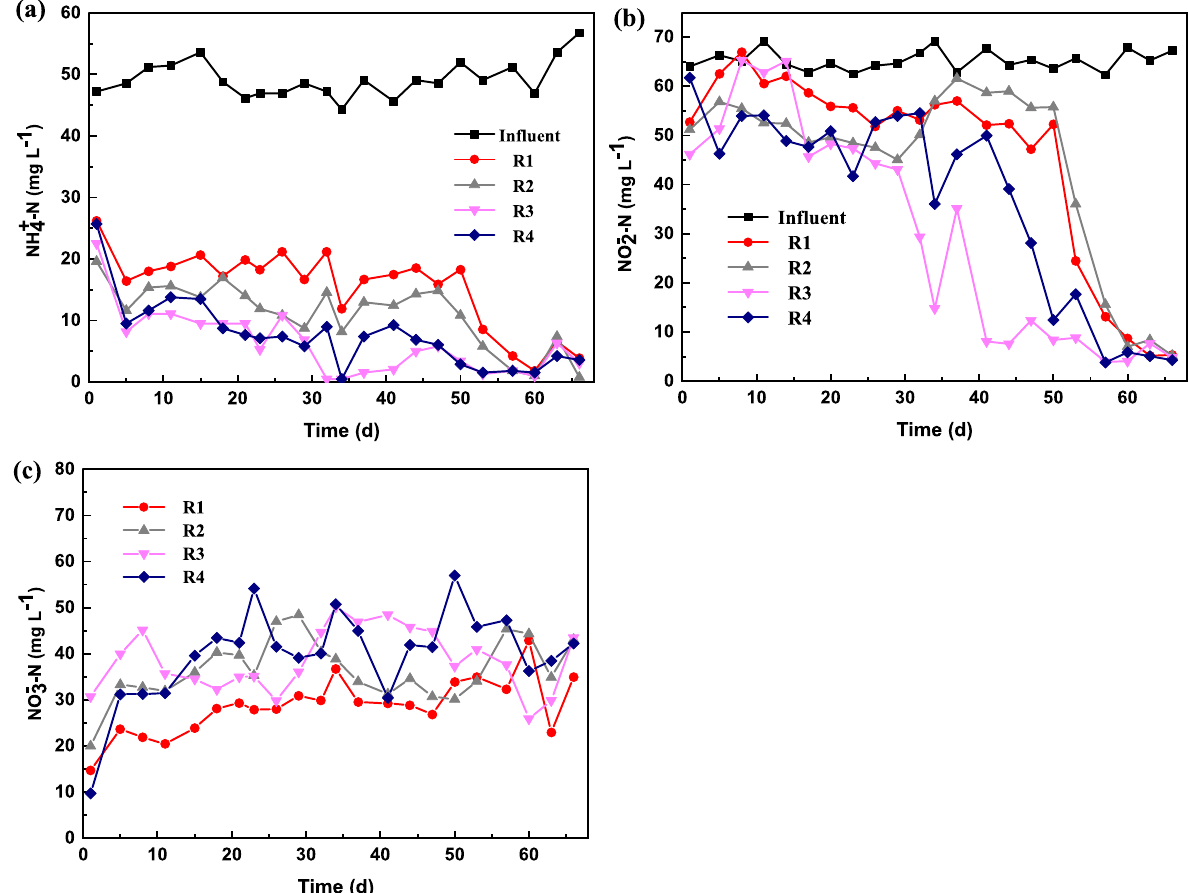
Fig. 1 Nitrogen removal performance of four reactors during the start-up period. a NH 4 + – N concentration (mg/L), b NO 2 − – N concentration (mg/L), c NO 3 − – N concentration